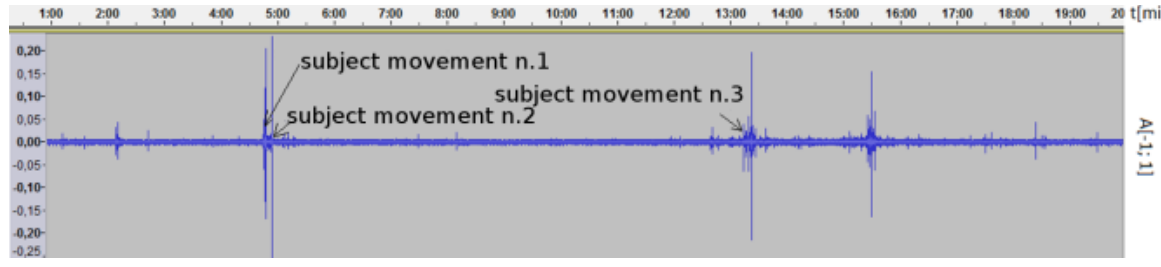
Figure 9. Recorded sound data of subject No.